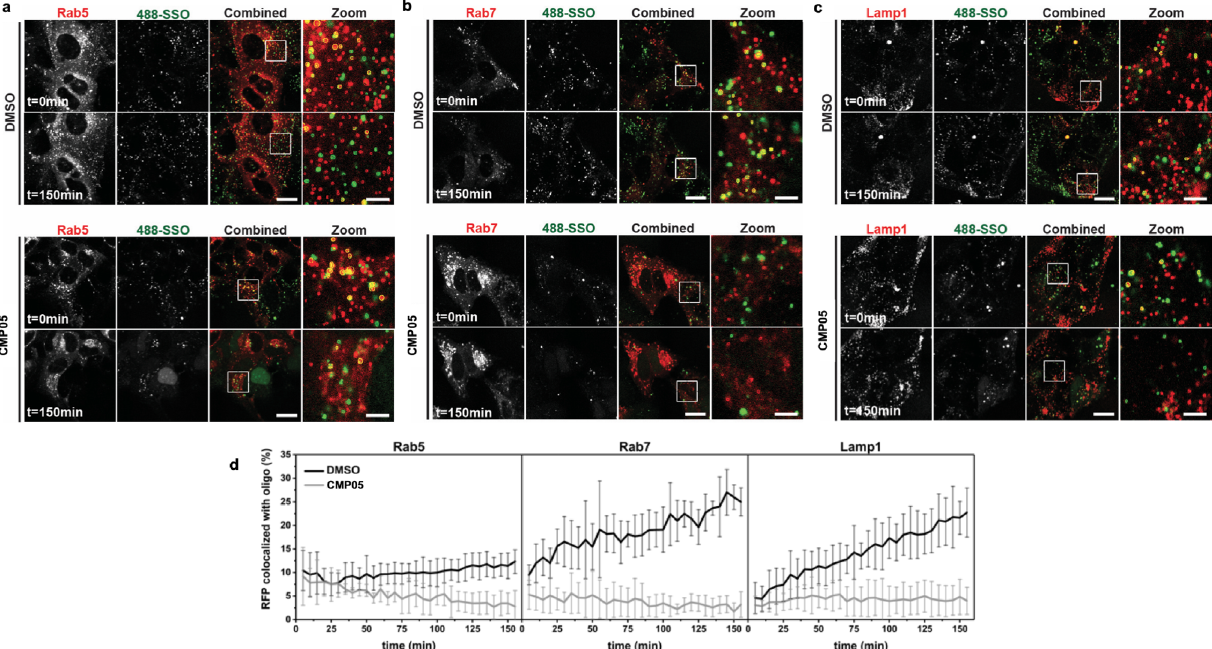
Fig. 7 Live-cell confocal microscopy images of SSO-endosome colocalization assay. a – c Live-cell microscopy of HuH7 cells overexpressing mRFP-Rab5 ( a ), mRFP-Rab7 ( b ) or Lamp1-RFP ( c ) after 15 min pulse-incubation with 1 µ M SSO and 2.5 µ M CMP05. The cells were continuously exposed to 2.5 µ M CMP05 and imaged over time. The images were analyzed for colocalization between 488-SSO and (m)RFP by the ComDet plugin to ImageJ and detected particles are marked with a circle (green for 488-SSO, red for (m)RFP and yellow for colocalized particles). Scale bars are 20 µ m in the full images and 5 µ m in the zoomed images. d Quantitation of (m)RFP colocalized with 488-SSO using the ComDet plugin. The data are presented as the percentage of detected (m)RFP-positive vesicles colocalized with SSO-positive vesicles ± SD (CMP05: Rab5 n = 4, Rab7 n = 4, Lamp1 n = 5; DMSO: all cell lines n =